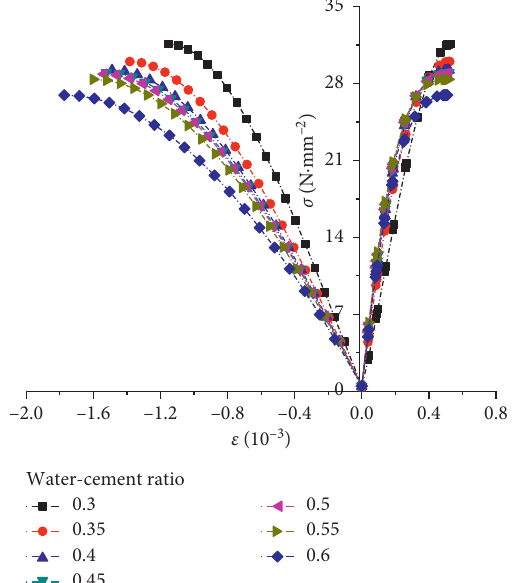
Figure 22: The impact of the water-cement ratio on the stress- strain curves of the FSSAC stub columns.